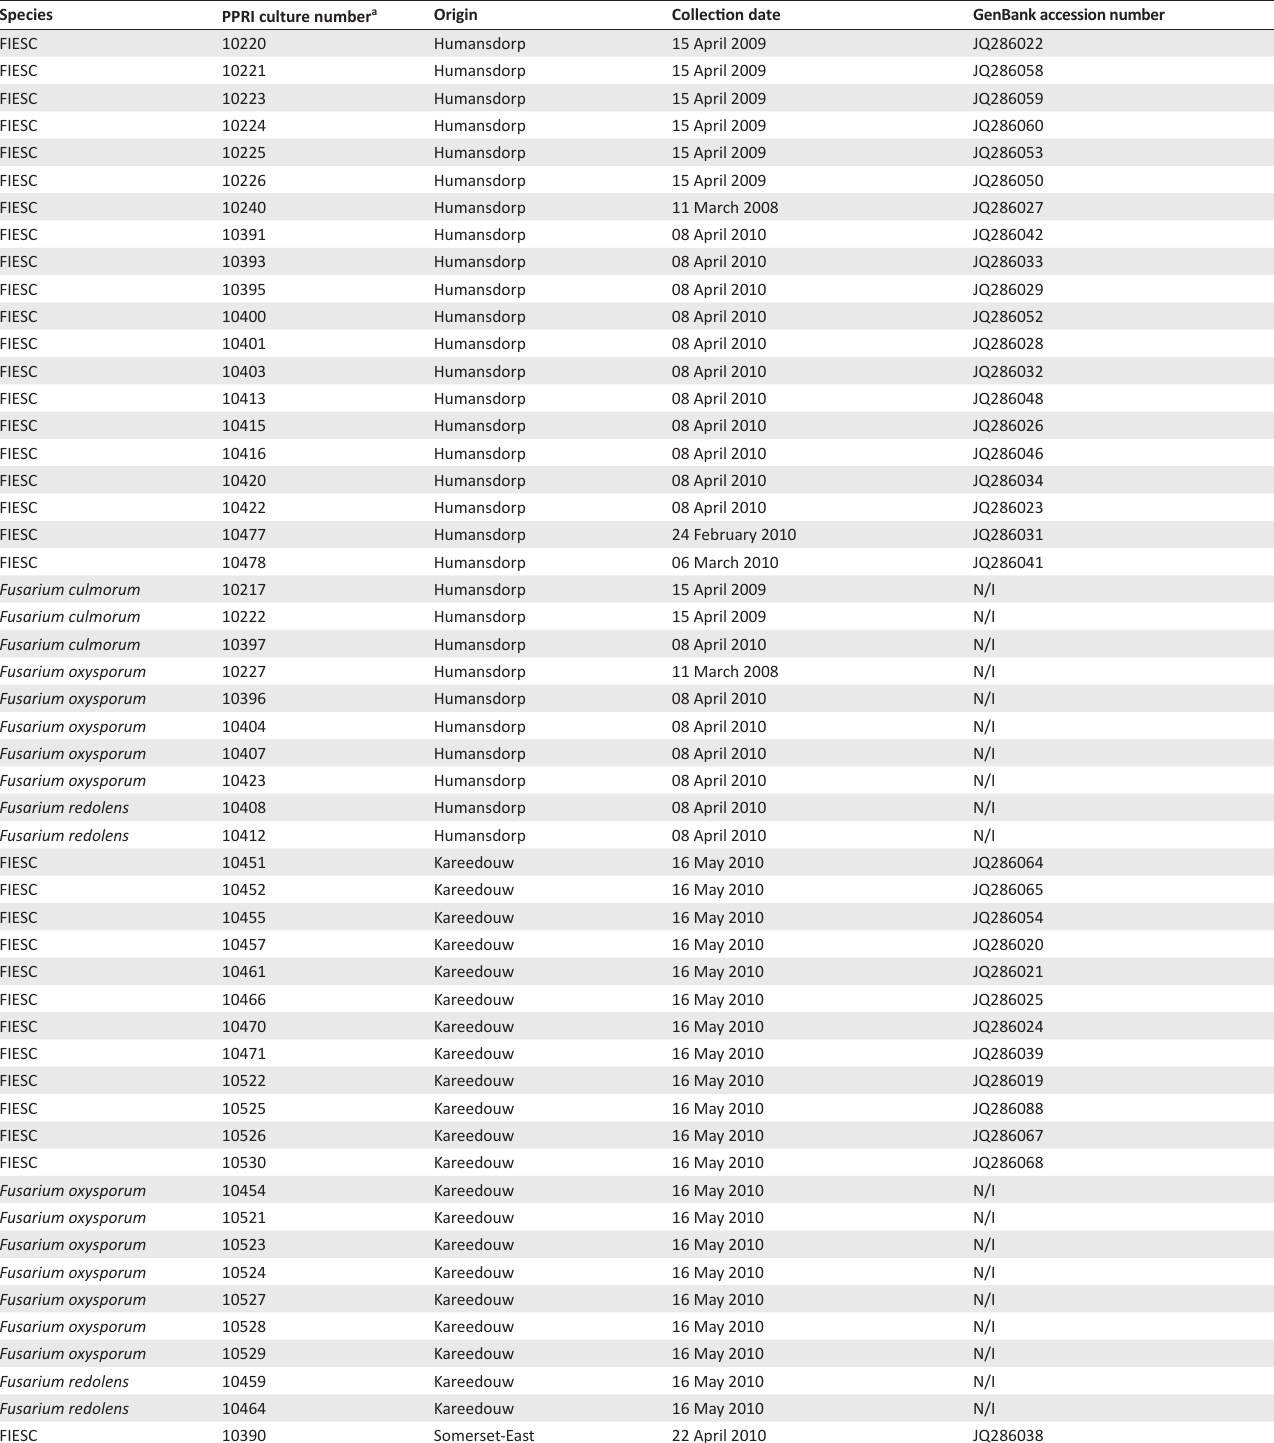
TABLE 1: Fusarium isolates obtained from Pennisetum clandestinum collected during kikuyu poisoning outbreaks in the Eastern Cape Province of South Africa.